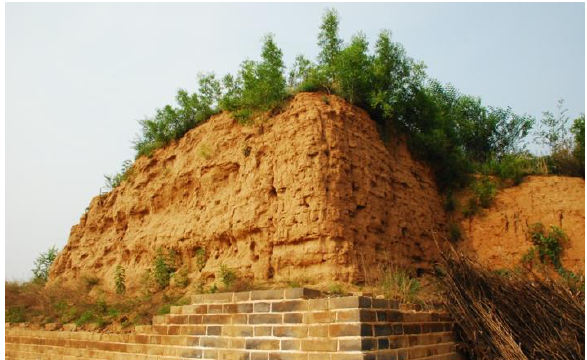
Figure 8. Present situation of human construction damage of the east town